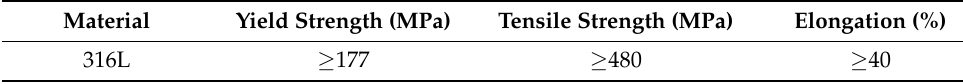
Table 3. Mechanical properties of 316L stainless steel plates.